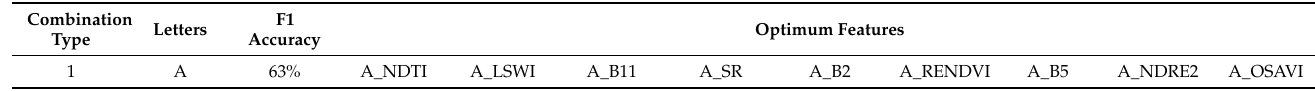
Table A8. Top-10 optimal soybeans feature sets for different combination types on 8 May 2020.